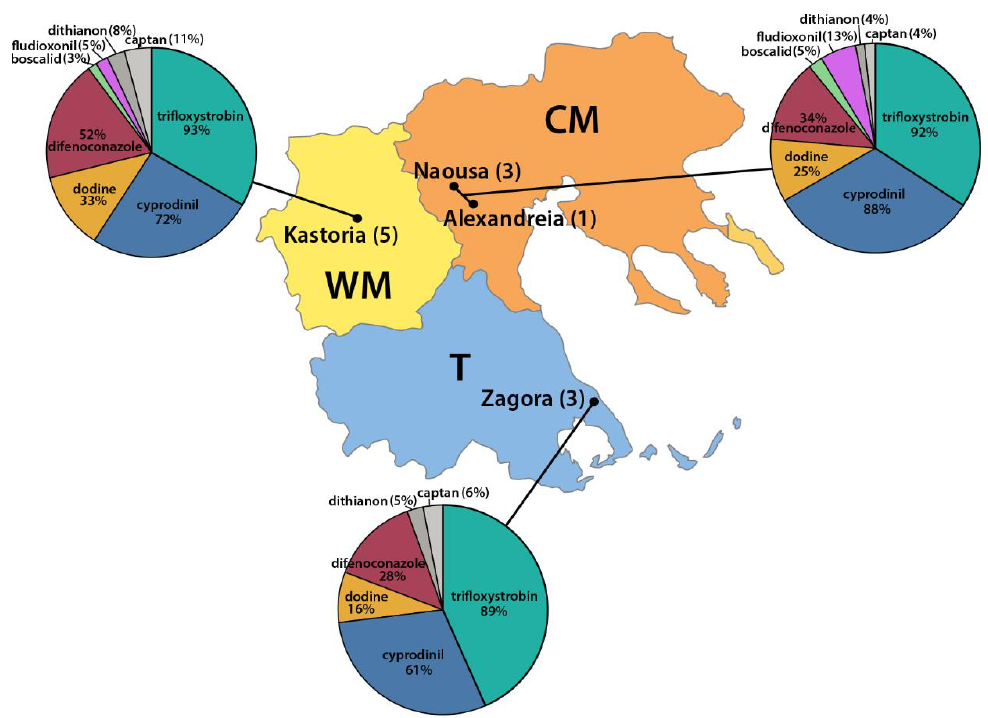
Figure 9. Frequency distribution of resistant V. inaequalis isolates to eight fungicides of unrelated chemical groups. Sampling sites in the regions of Western Macedonia (WM), Central Macedonia (CM), and Thessaly (T).